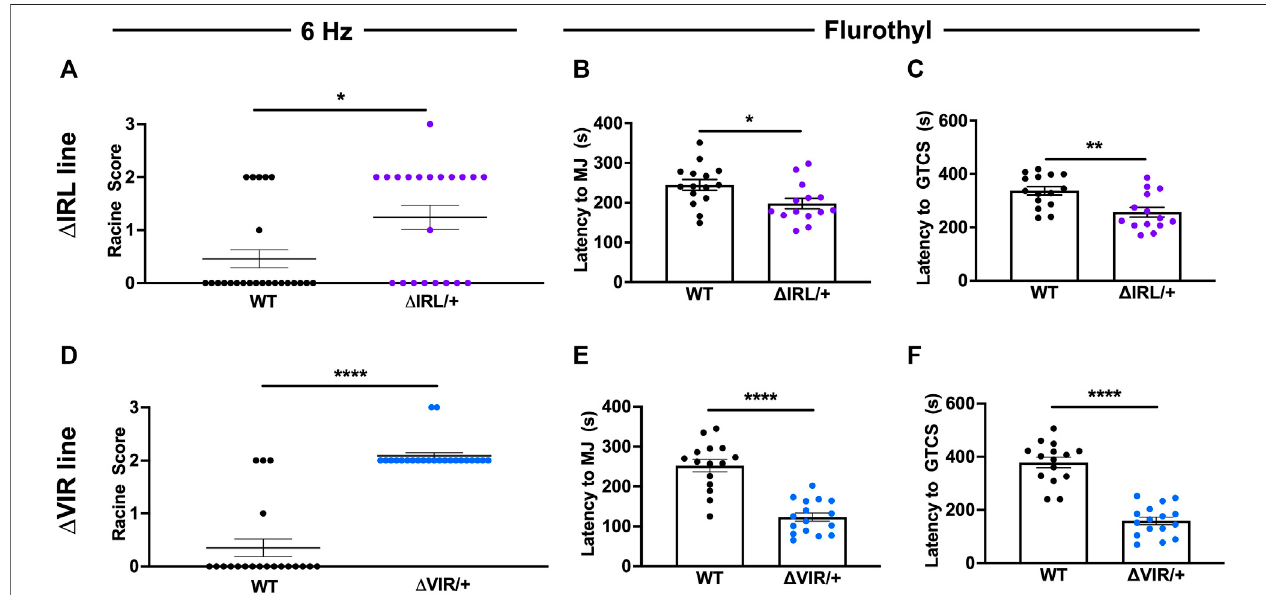
FIGURE 3 | Δ IRL/+ and Δ VIR/+ mutants exhibit increased seizure susceptibility. (A) Δ IRL/+ mutants are signi fi cantly more susceptible to 6 Hz-induced seizures compared to WT littermates. Mann-Whitney test. WT N (cid:1) 25; Δ IRL/+ N (cid:1) 21. (B,C) Δ IRL/+ mutants exhibit a lower average latency to the fi rst MJ ( B ) and GTCS (C) compared toWT littermates. Unpaired student ’ s t test. WT N (cid:1) 15; Δ IRL/+ N (cid:1) 14. (D) Δ VIR/+ mutants aremore susceptible to6 Hz-induced seizures compared to WT littermates.Mann-Whitney test.WT N (cid:1) 20; Δ VIR/+: N (cid:1) 23. (E,F) Δ VIR/+mutantsexhibitloweraveragelatenciestothe fi rstMJ (E) andGTCS (F) comparedtoWT